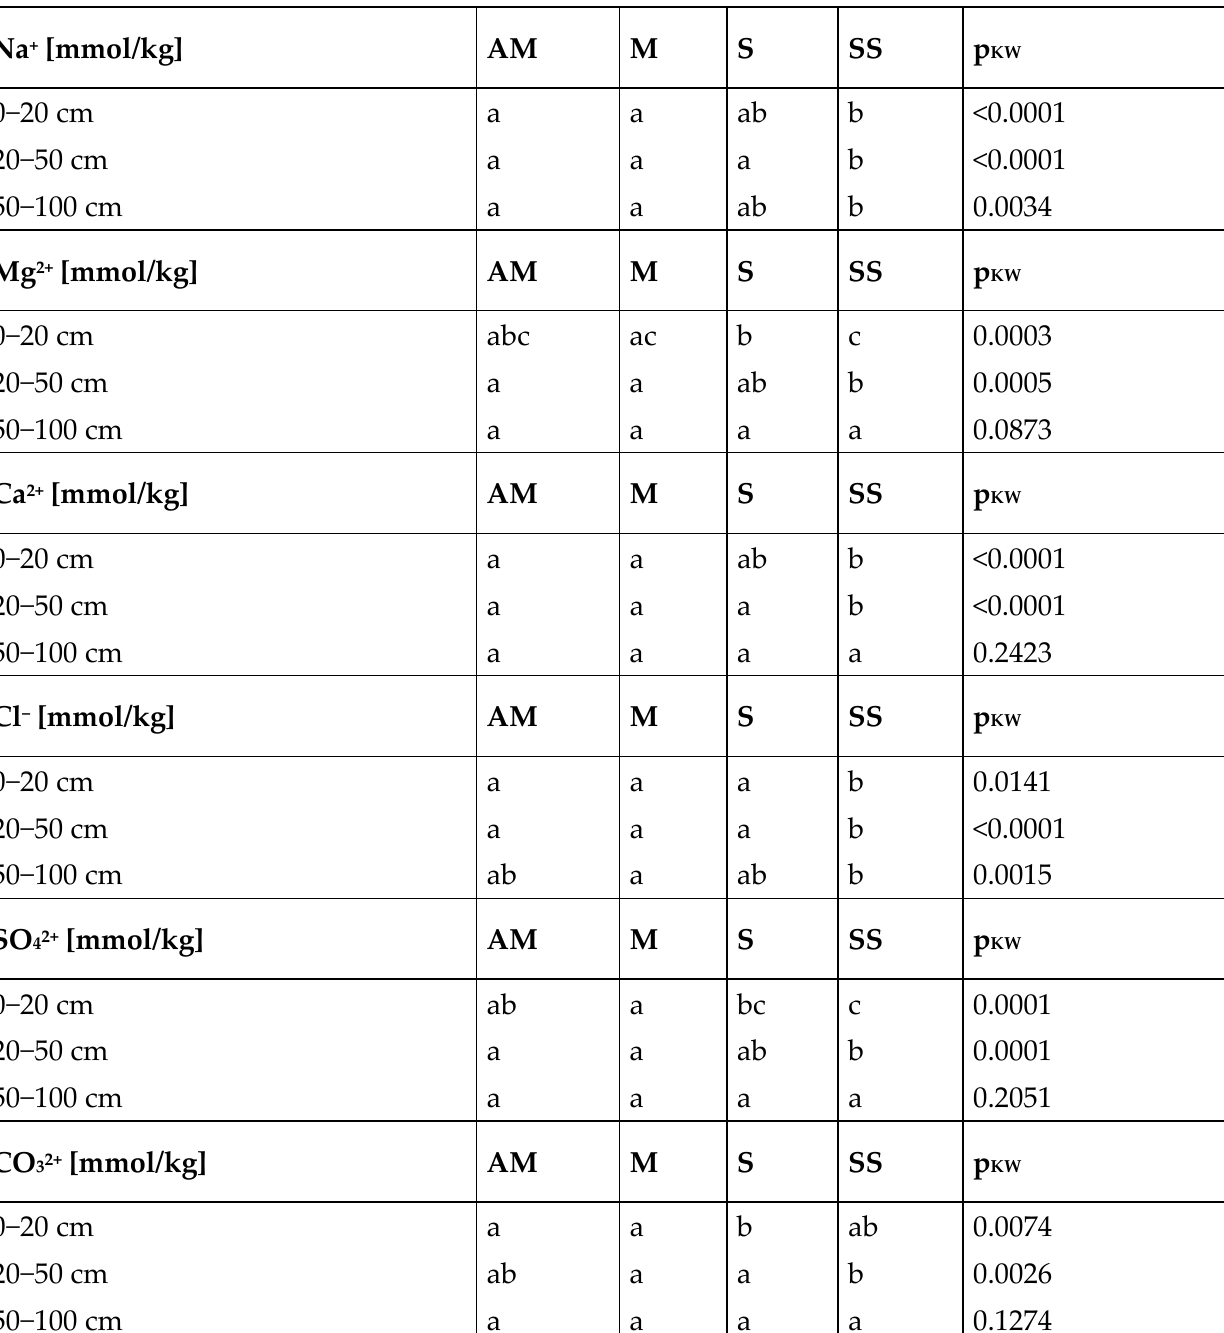
Figure 4. The mean content of cations and anions of soluble salts in 3 soil horizons of studied soils [cmol/100g soil] with statistically significant differences between the studied soil types and p values in Kruskal–Wallis tests provided in the table. Abbr.: alluvial meadow soil (AM), meadow soils (M), serozems (S), and secondary solonchaks (SS).